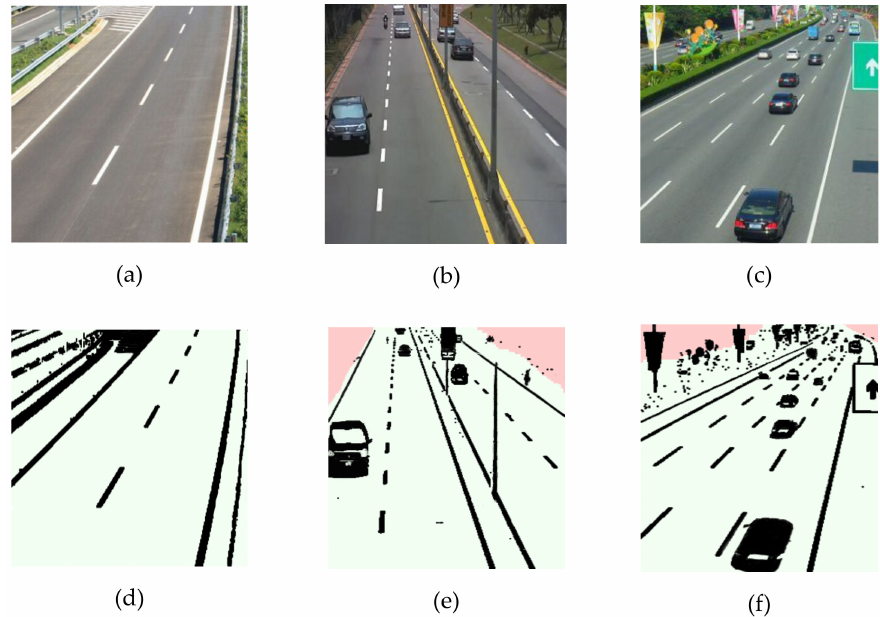
Figure 4. Segmentation results of the HMRF model on clear and nonclear roads of the local dataset. From top to bottom are original and output images ( a – f